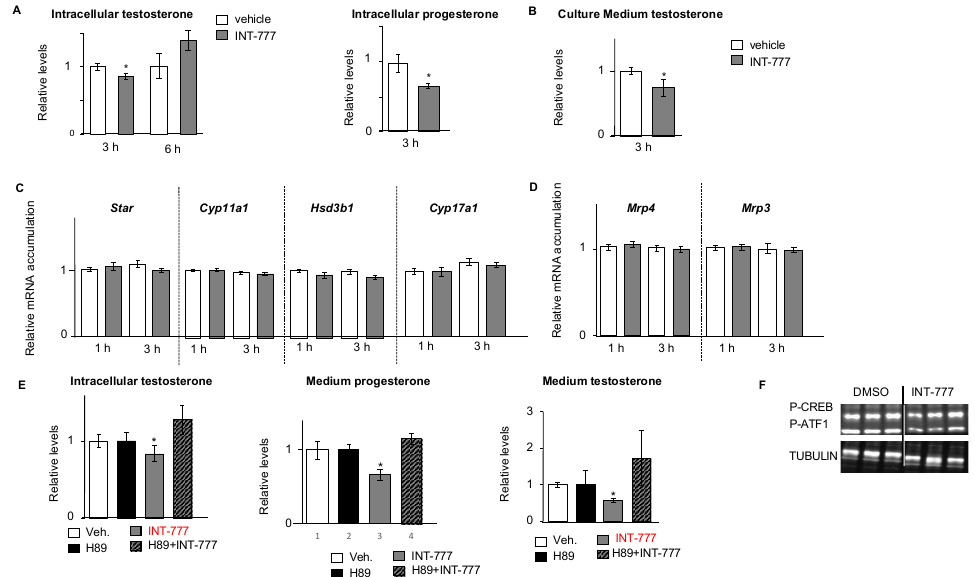
24 h was observed on hCG-induced testosterone levels in mLTC1 cells (Figure 3B). Com- bined, these data suggest that TGR5 must be a local regulator of testosterone synthesis that does not modulate the central regulation by LH/CG.